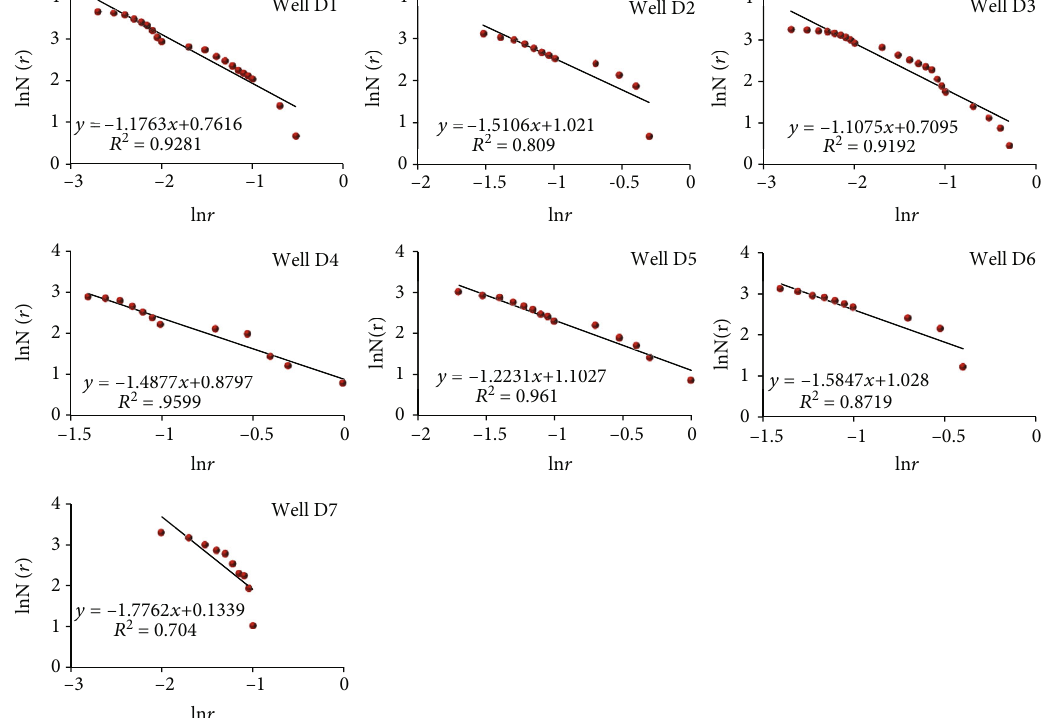
Figure 7: ln N ð r Þ − ln r of wells